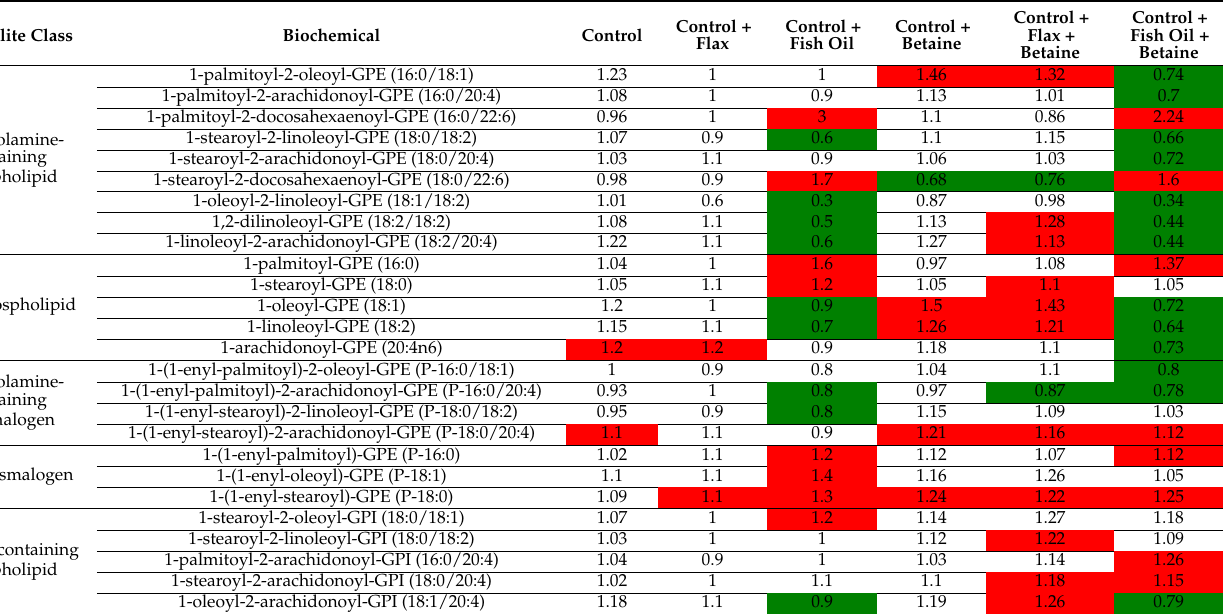
Table 9. Ethanolamine- and inositol-containing phospholipids which changed during the study while consuming control, or betaine, flax, and fish oil supplemented foods *.